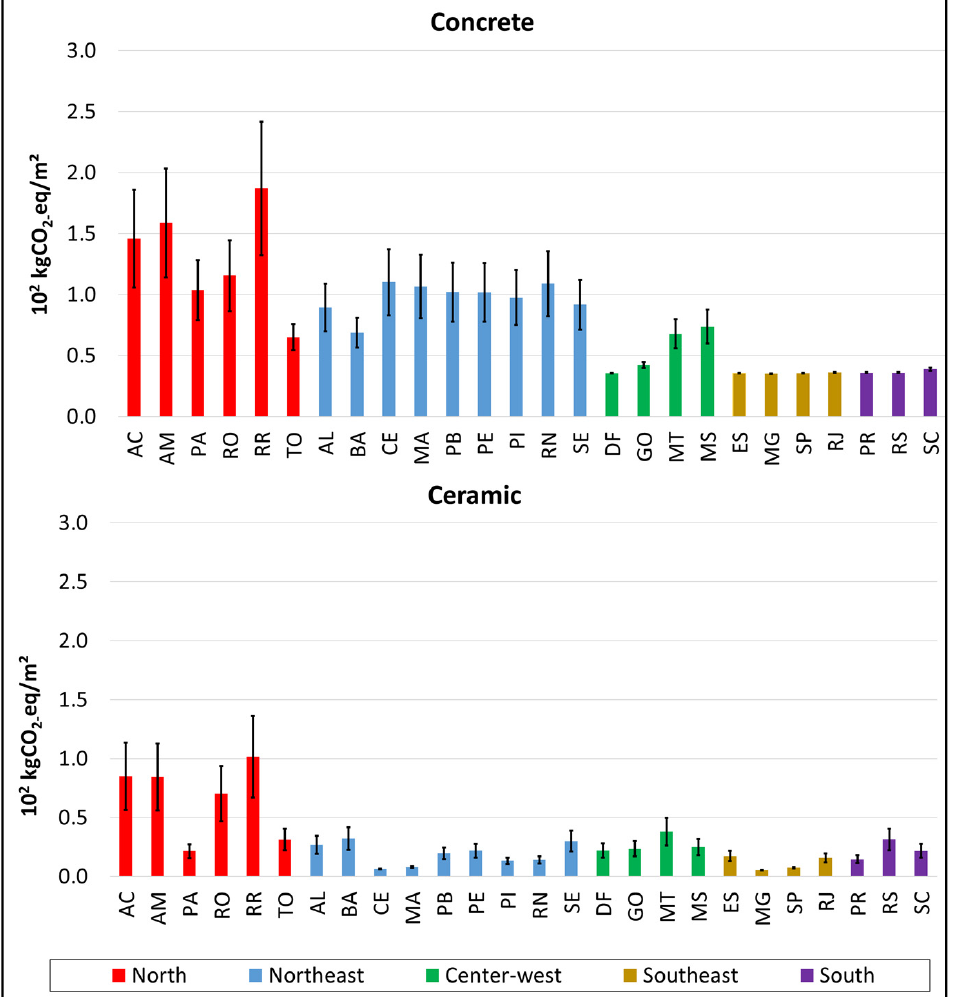
Figure 3. Total Climate Change impacts. The error bars represent the standard deviation due to transportation scenarios.